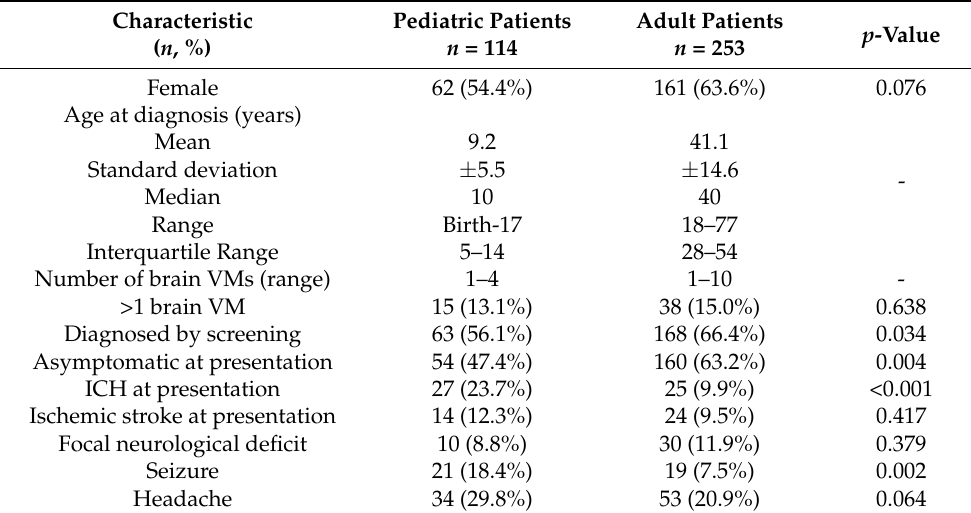
Table 1. Demographic and clinical characteristics of pediatric and adult HHlT patients with Brain VMs.